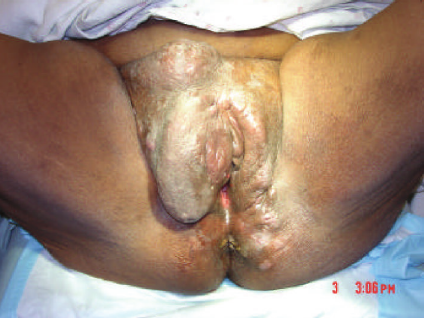
Figure 1: Nodular, firm, nonmobile vulvar mass extending from the right labia majora.